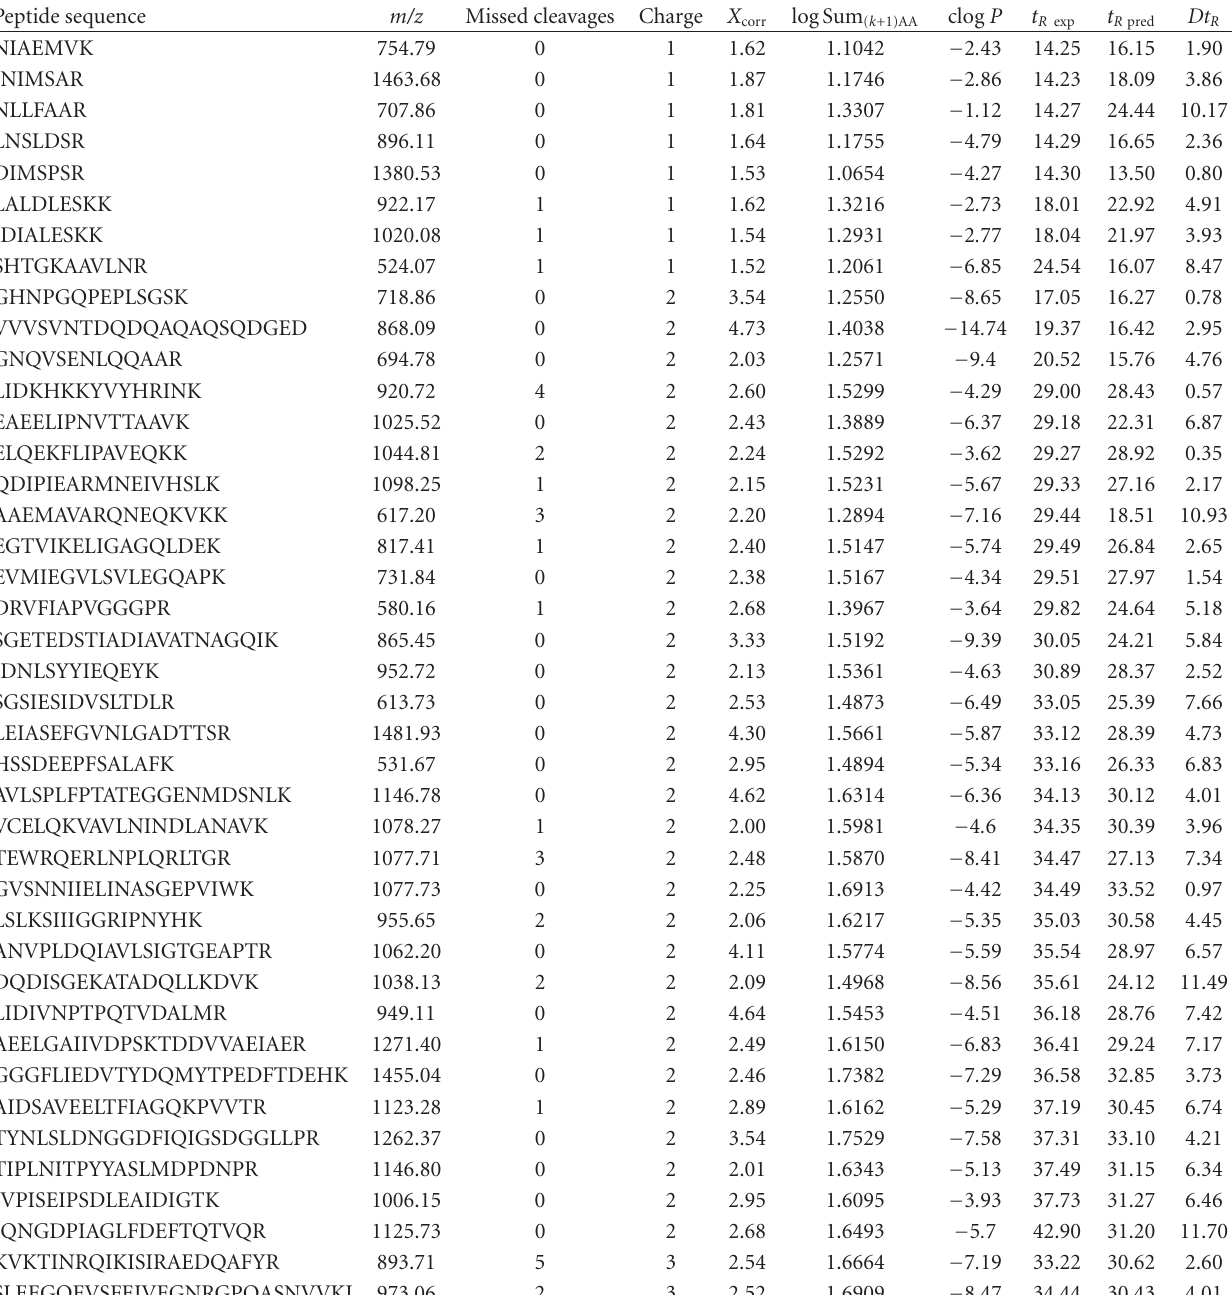
Table 4: Test peptides from proteins of Bacillus subtilis proteome, identified on the basis of one peptide with X corr above 1.5. Peptide